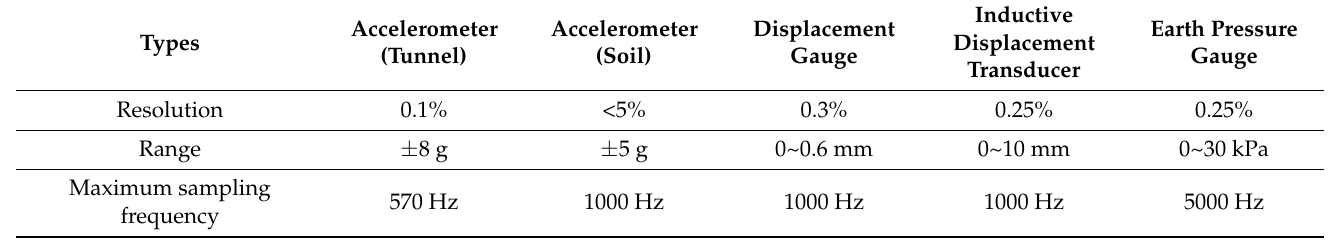
Table 4. Instrument parameters.